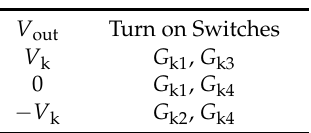
Table A1. Generalized switching logic for a cascaded